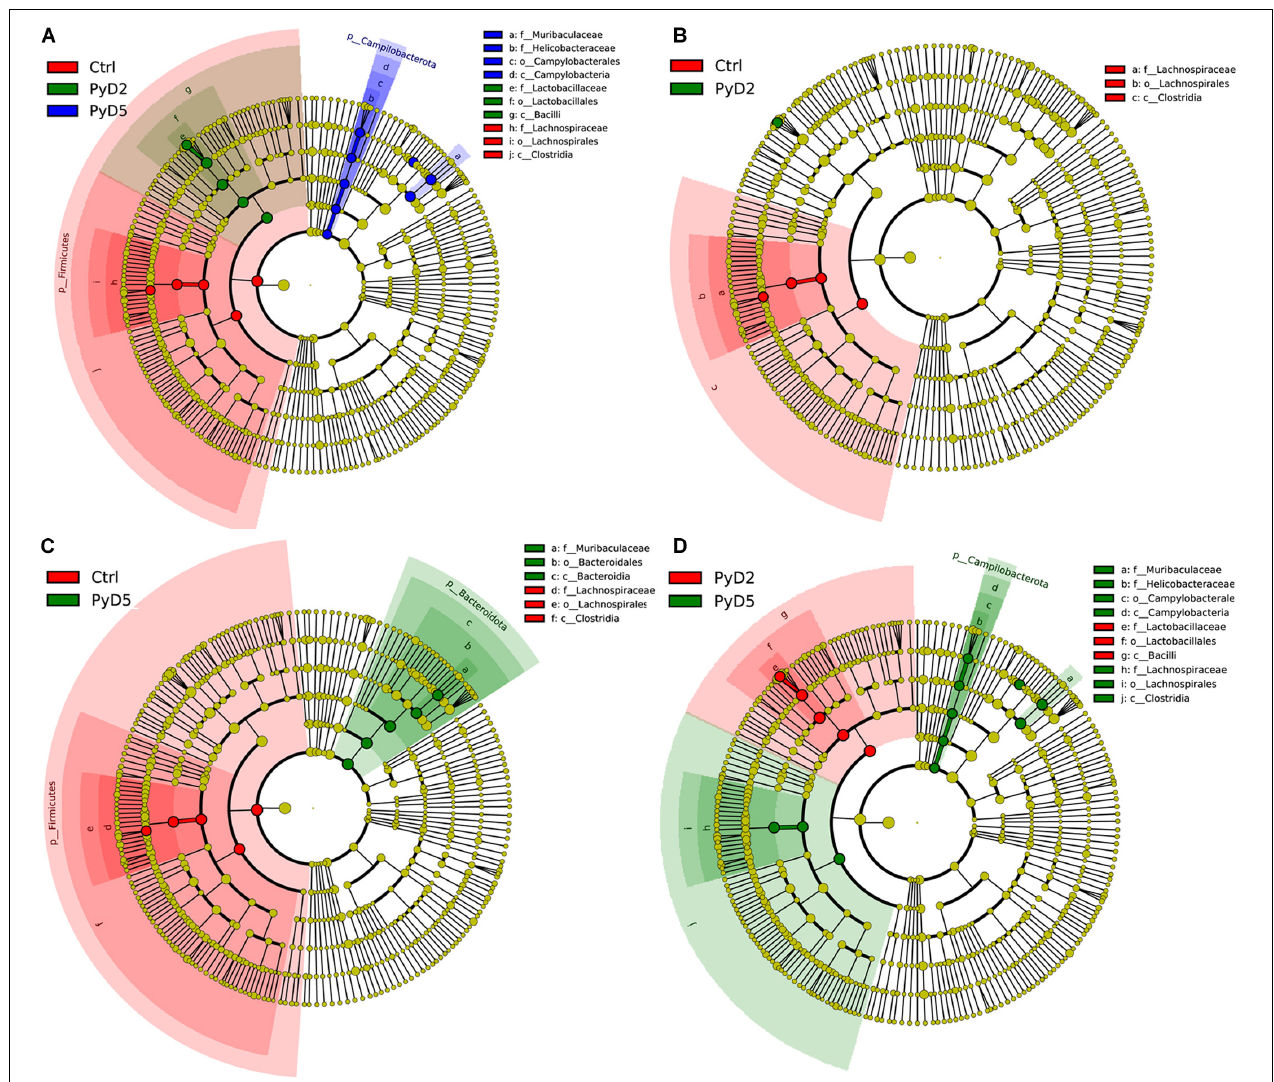
FIGURE 6 | Cladogram of the most differentially abundant bacterial taxa among three groups. The red, green, and blue colors represent the bacterial communities of Ctrl, Py D2, and PyD5 groups, respectively. (A) Cladogram of the most differentially abundant bacterial taxa in the Ctrl, PyD2, and PyD5 groups. (B) Cladogram of the most differentially abundant bacterial taxa in the Ctrl and PyD2 groups. (C) Cladogram of the most differentially abundant bacterial taxa in the Ctrl and PyD5 groups. (D) Cladogram of the most differentially abundant bacterial taxa in the PyD2 and PyD5